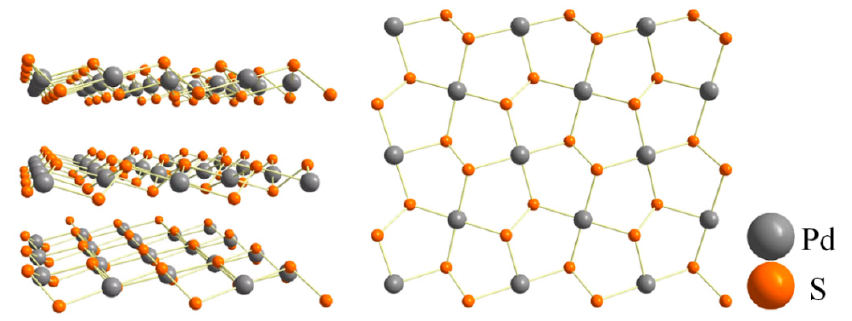
Figure 1. Atomic structure of 2D layered PdS 2 .